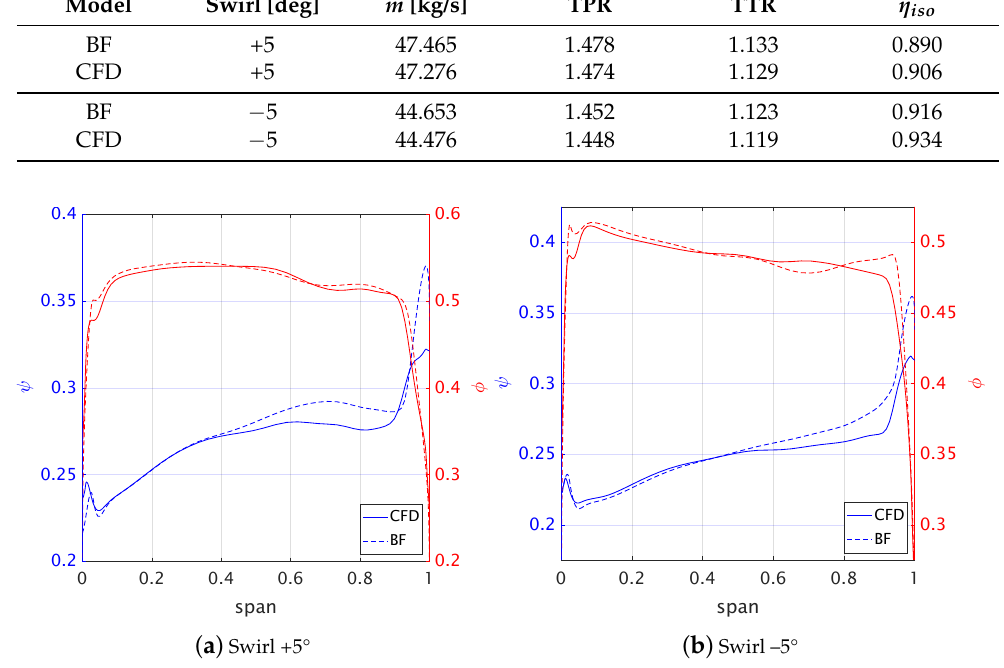
Figure 18. Spanwise distributions downstream of rotor blade of work and flow coefficient for pre- swirled flow near peak